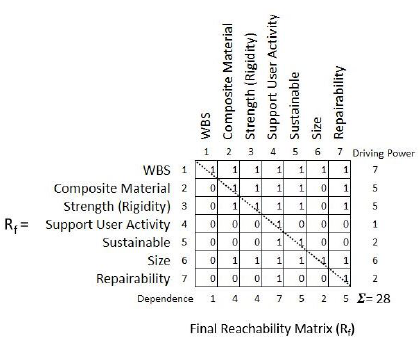
Figure 28. Interpretive Structural Modeling (ISM) Final Reachability Matrix with Driving Power and Dependence